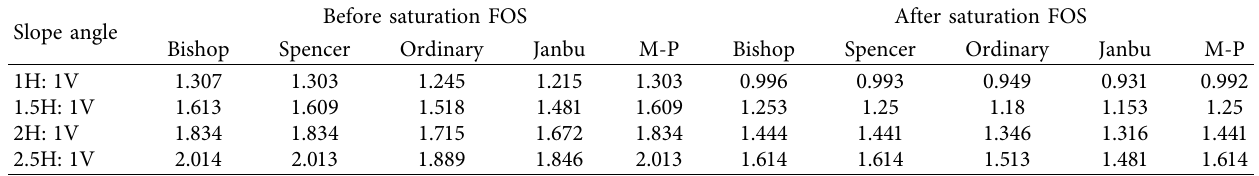
Table 13: FOS values for slope-6 for different slope angles before and after